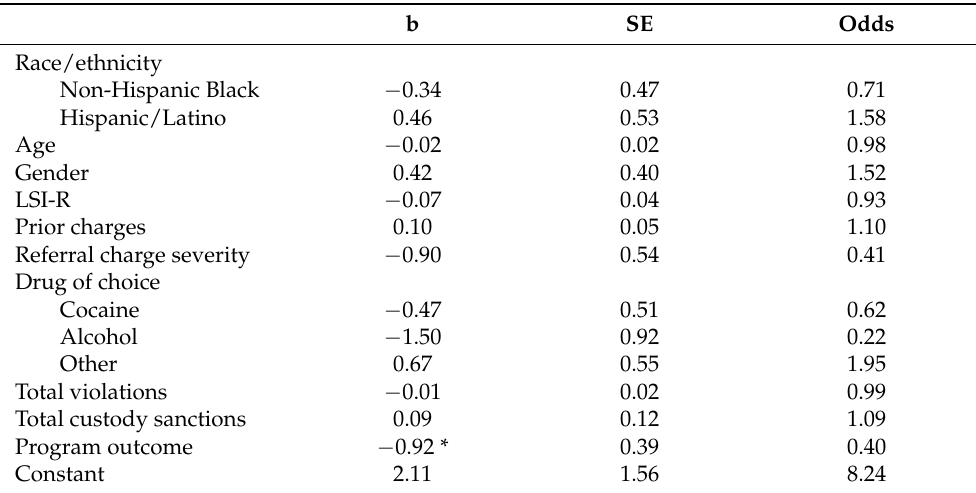
Table 8. Logistic Regression Results for Likelihood of Recidivism ( N =